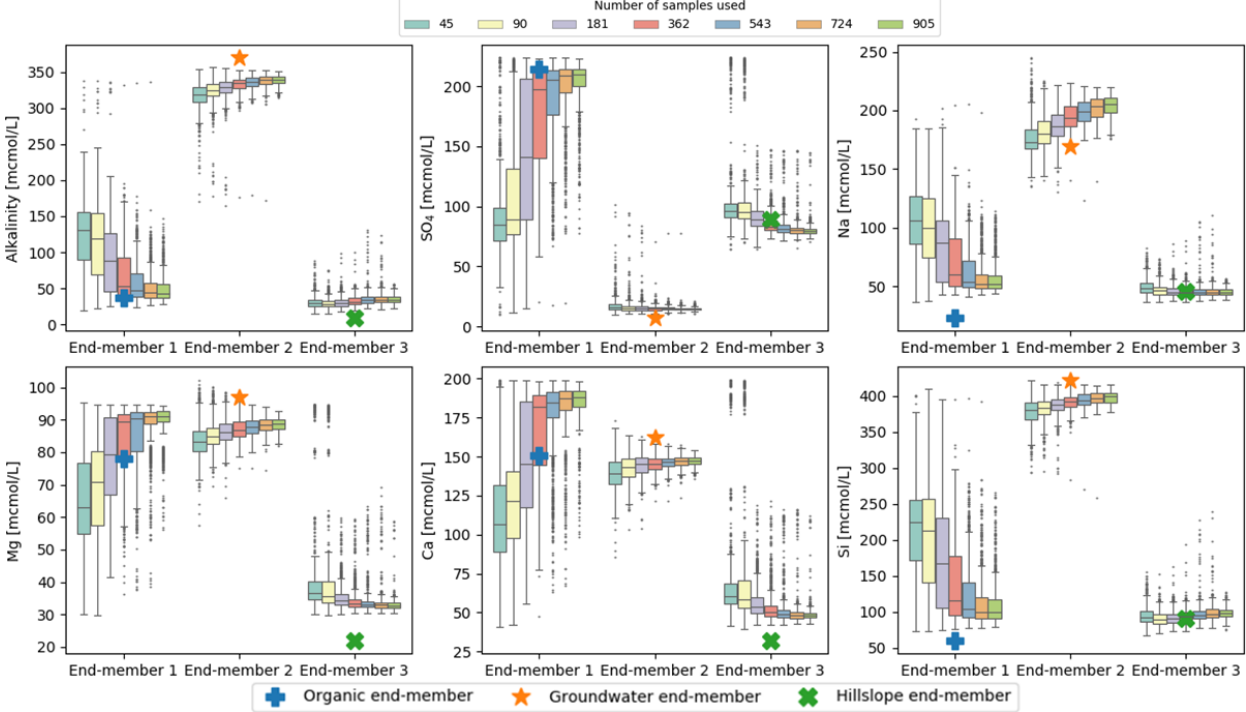
Figure 6. CHEMMA end-members predicted with varying sample size grouped by the corresponding three field measured end-members. Each sample size box is drawn from 1000 bootstrap samples with the size of the number of sample used.